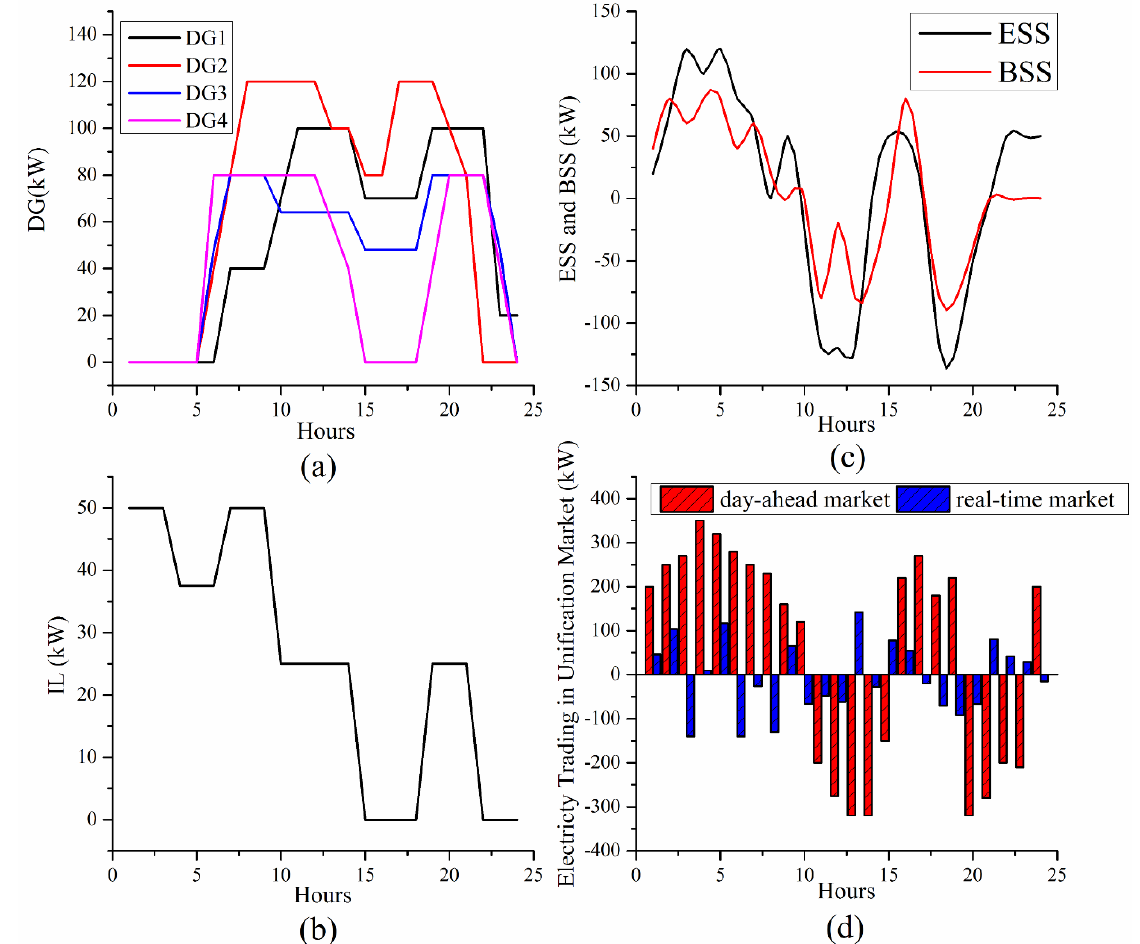
Figure 5. ( a ) Generation scheduling of DGs; ( b ) Interruptible loads; ( c ) Charging and discharging behaviors of BSS and ESS; ( d ) Electricity transaction in unification